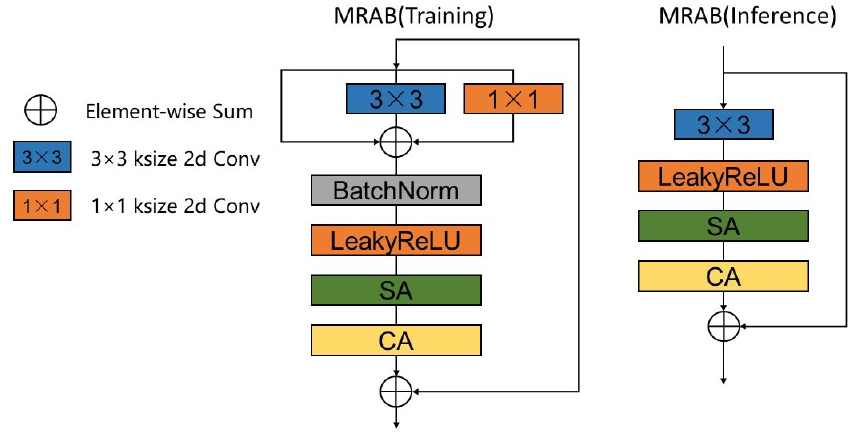
Figure 3. Structures of MRAB during training ( left ) and during inference ( right